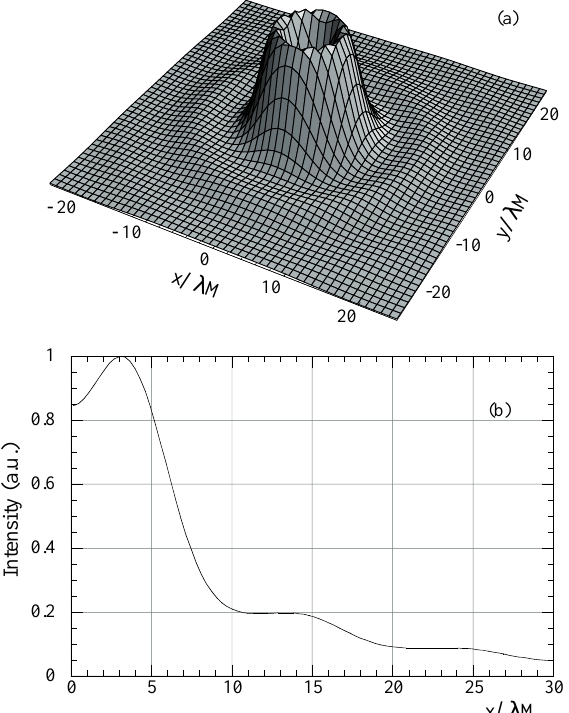
FIG. 6. 3D plot of the radial SPF (a) and its projection on the (cid:120) axis (b) for 0.5% cutoff level. The vertical scale in the 3D plot is the intensity in arbitrary units. u (cid:108)(cid:101)(cid:110)(cid:115) (cid:173) (cid:48)(cid:46)(cid:49) and bg (cid:173) (cid:49)(cid:48)(cid:48)(cid:48)